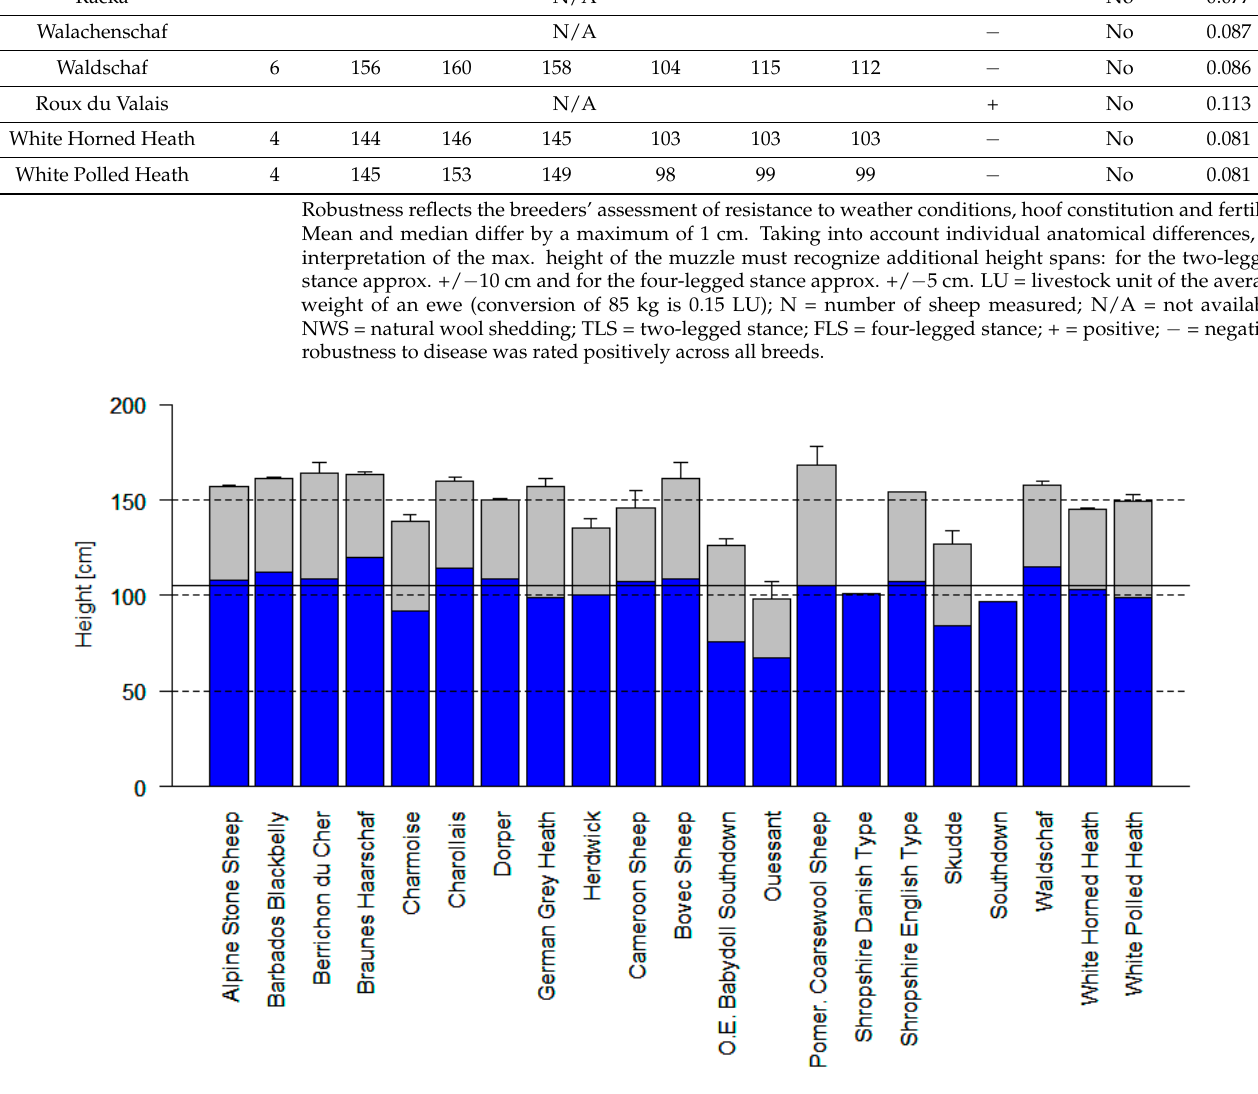
Figure 5. The muzzle heights of the sheep breeds studied. The dark blue area shows the average height of the muzzle, which is reached in the four-legged stance with the neck stretched. The gray area shows the range of heights that can additionally be reached in the average of the measurements, given the ability to stand bipedally. The whiskers show the maxima of the measurements (for number see Table 3). The solid line at 105 cm is the height of the lowest wire, which was proved to be favorable for deployment of the Shropshire Danish type in our own field trial (several weeks of deployment in the Guyot system during the vegetation period is possible). The lower limit is 105 cm (see below). Within the English type of Shropshire, there appear to be many suitable animals that are not capable of standing bipedally. O.E. = Olde English; Pomer. =